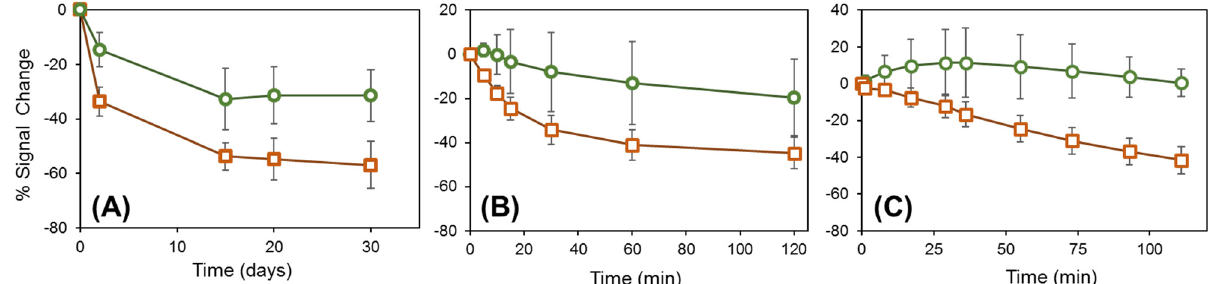
Figure 4. Percentage signal change for the tridentate thiol TA-1 (circles) and the monodentate thiol MA-1 (squares) probe films when ( A ) stored in PBS buffer at 4 °C for 30 days; ( B ) immersed in PBS buffer at 40 °C for 2 h; and ( C ) immersed in PBS buffer containing 2 mM dithiothreitol (DTT) at room temperature [67]. Reprinted from Ref.